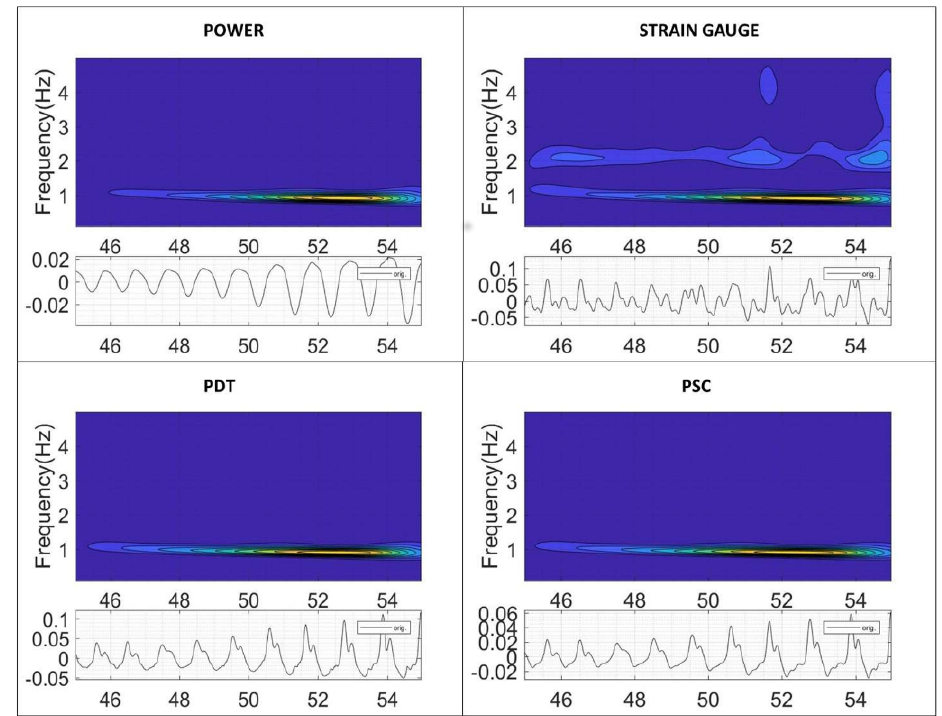
Figure 9. Onset of the instability. Time (s) and time-frequency